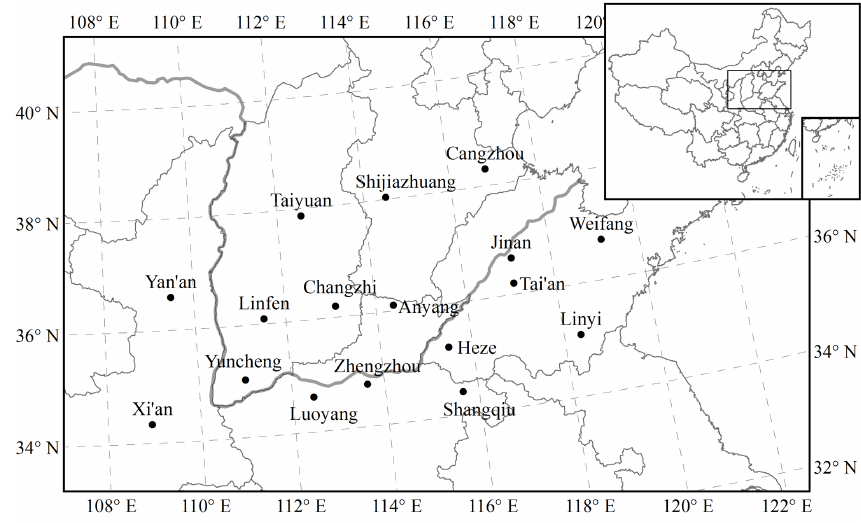
17 sites (Fig. 1) located in the NCP